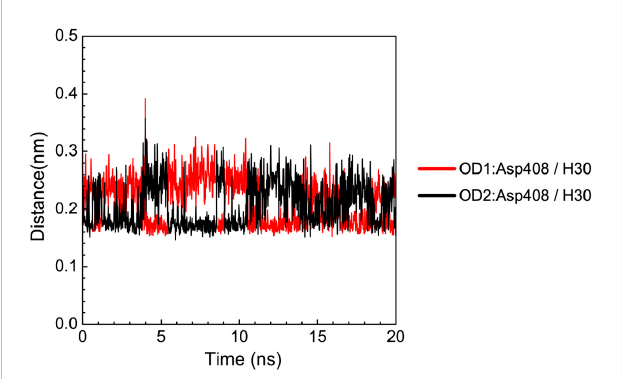
Figure 13. Distance variation of H-bonds for paraplegin complexes with 3-(2-carboxyphenyl)-4(3 H )-quinazolinone during MD simulation. Display the distances between compound and amino acid Asp408.